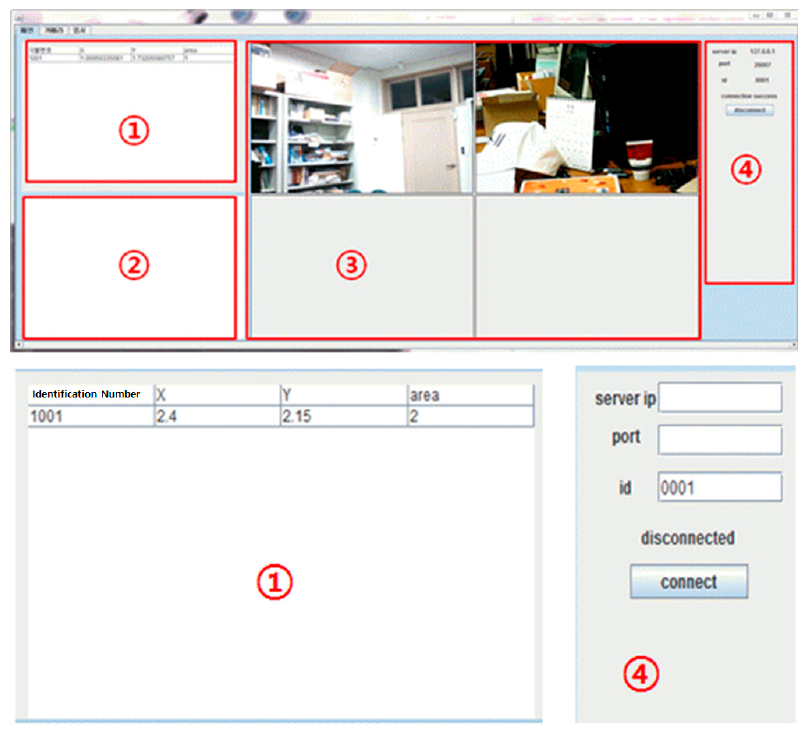
Figure 8. A basic screen of the camera-based monitoring program. Figure 8. A Basic Screen of the Camera-based Monitoring Program. Figure 8. A Basic Screen of the Camera-based Monitoring Program.